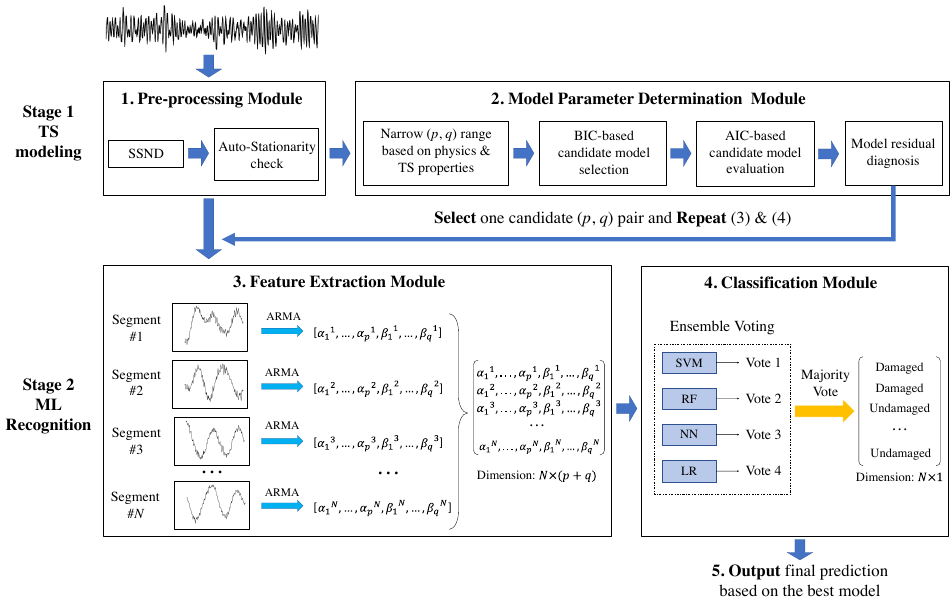
Figure 1. The proposed two-stage ARIMA-ML